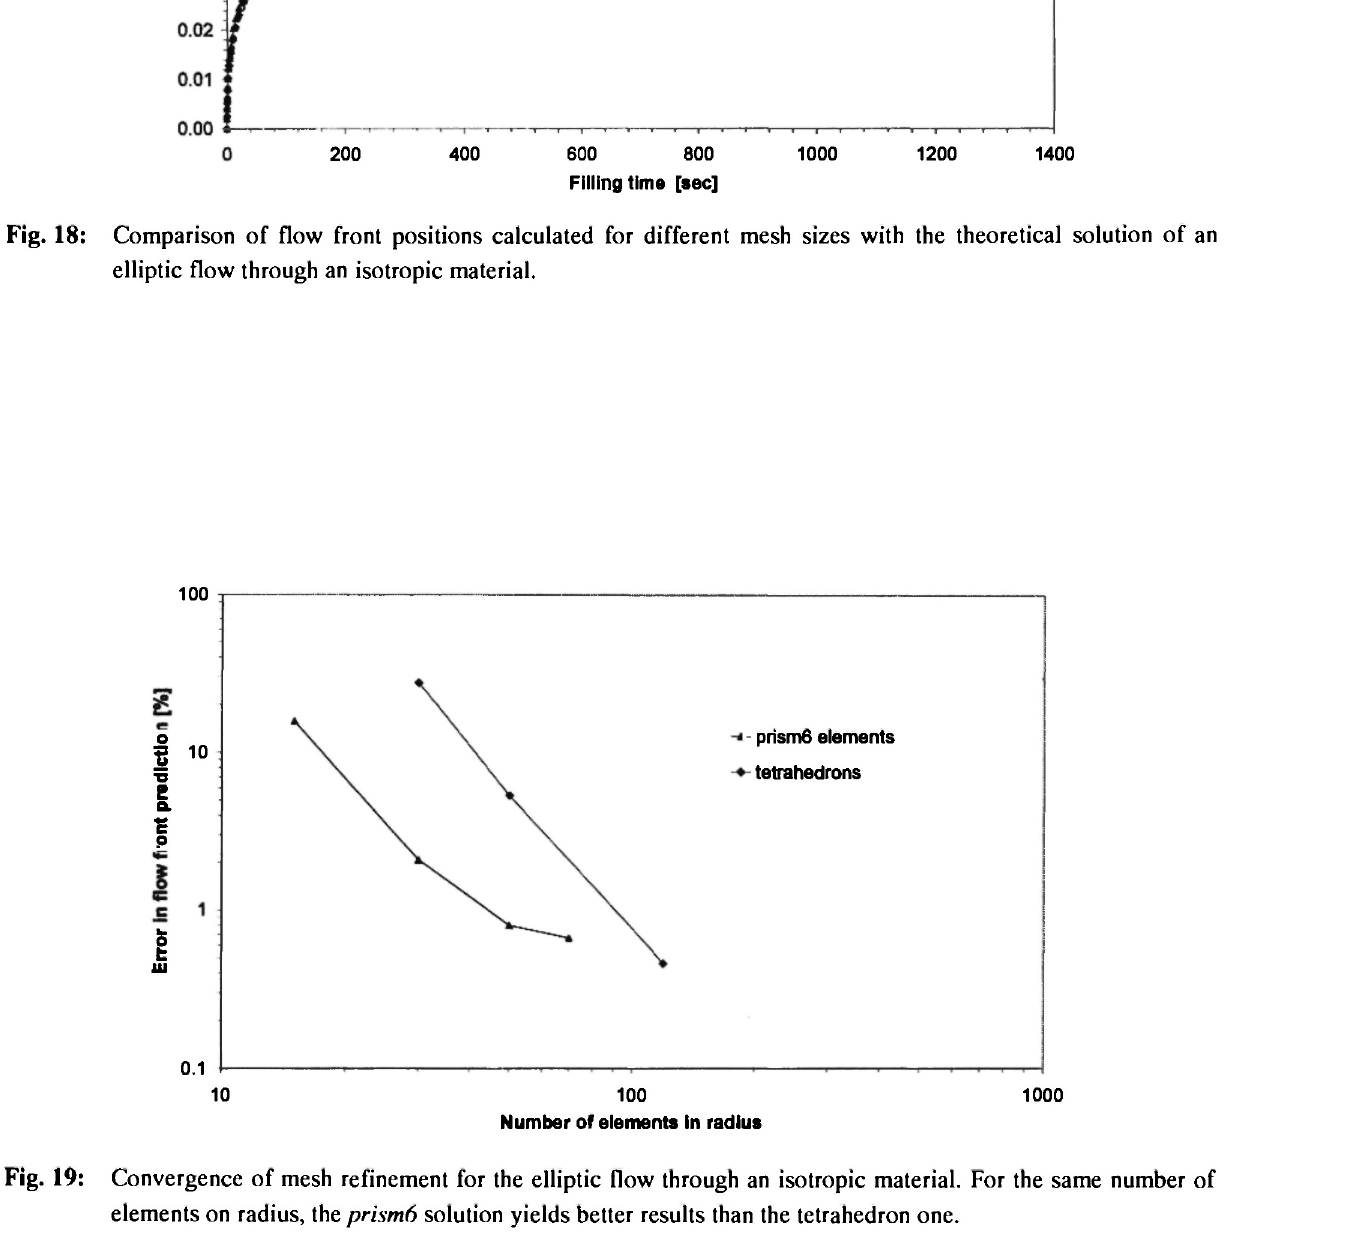
Convergence of mesh refinement for the elliptic flow through an isotropic material. For the same number of elements on radius, the prism6 solution yields better results than the tetrahedron